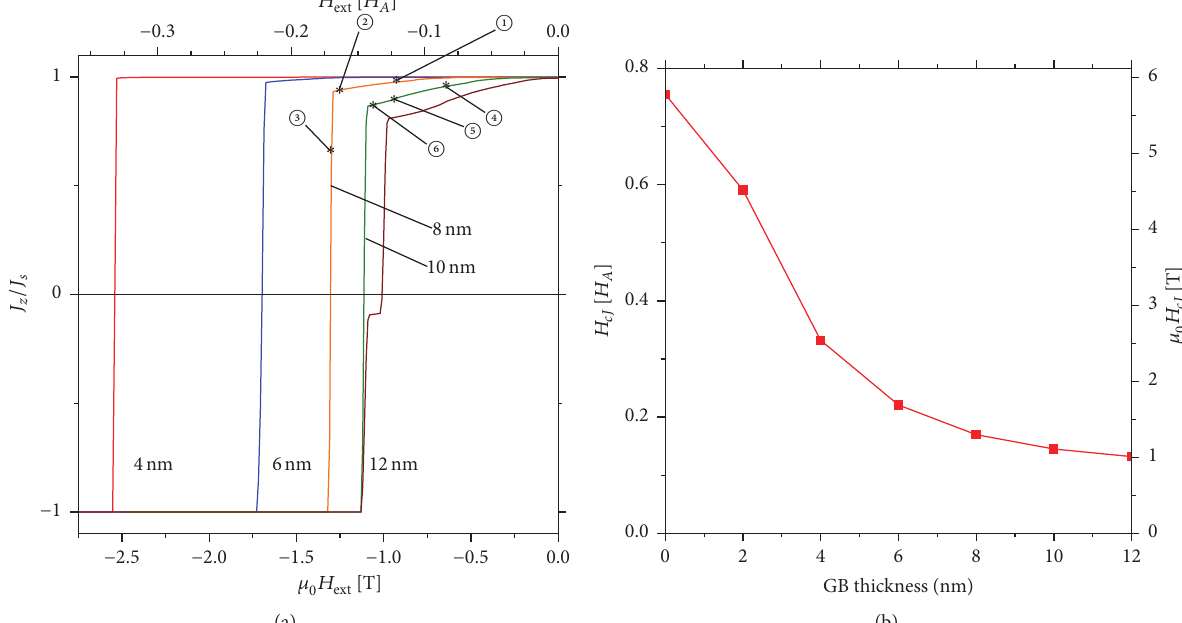
Figure 10: (a) Hysteresis curves of the 8-G model structure with a GB thickness ranging from 4 nm to 12nm and 𝜗 0 = 0 ∘ ; points A – F correspond to the magnetic configuration in Figure 11. (b) Influence of the GB thickness (0 nm–12nm) on 𝐻 𝑐𝐽 in the 8-G model structure for ∘ . 𝜗 0 = 0